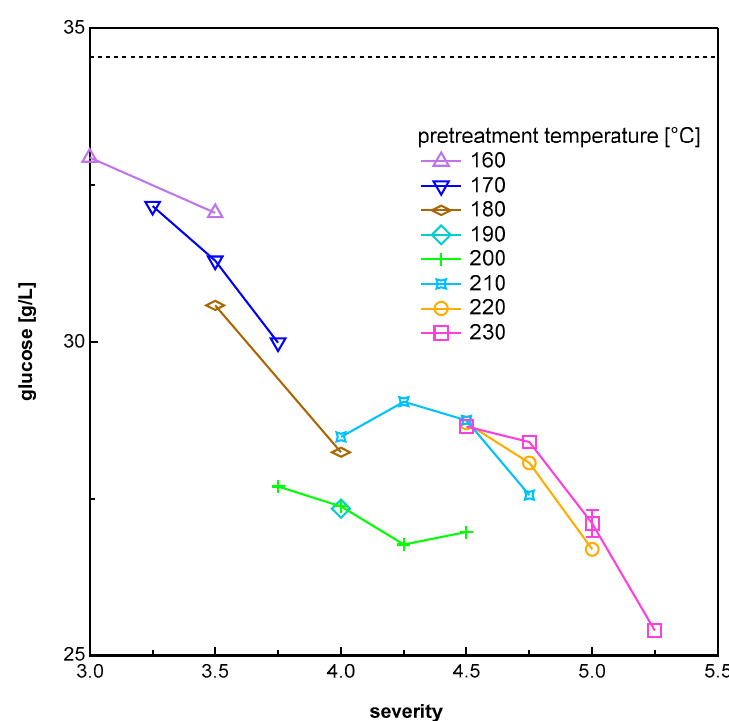
Figure 8. Effect of inhibitors in the steam explosion pretreatment hydrolysates on the enzymatic hydrolysis of Avicel. Shown are the final glucose concentrations after 168 h in the enzymatic hydrolysis of Avicel in the presence of different steam explosion prehydrolyzates as a function of pretreatment severity and temperature. The dashed horizontal line denotes the glucose concentration in the control without prehydrolyzate.